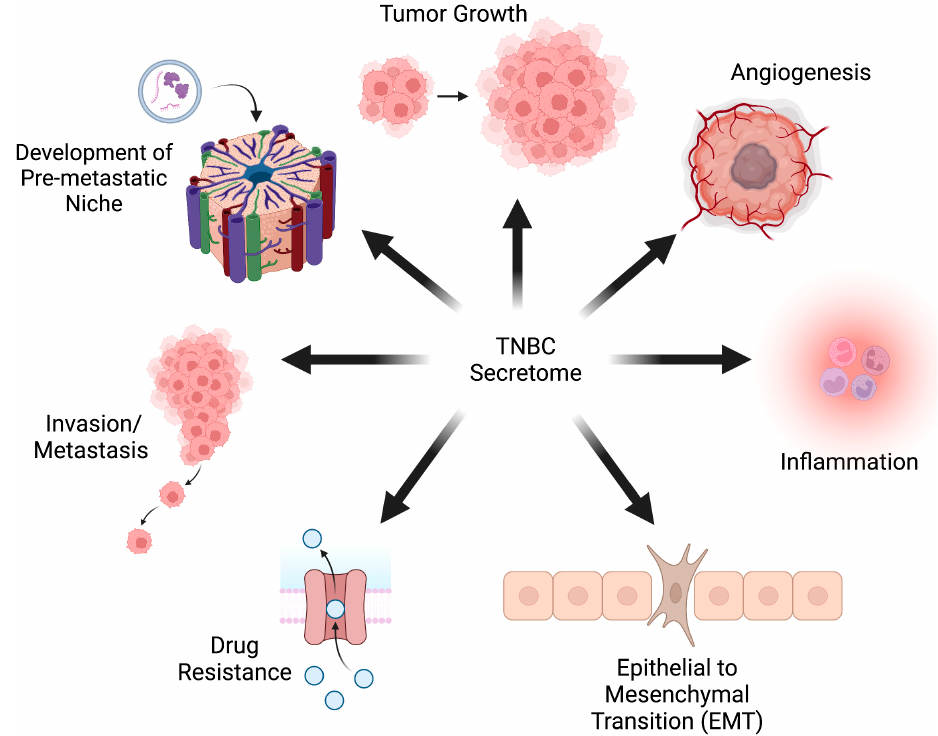
Figure 2. Effects of the TNBC secretome. Protein factors secreted by TNBC cells and tumors regulate cancer-promoting processes (Created with BioRender.com).